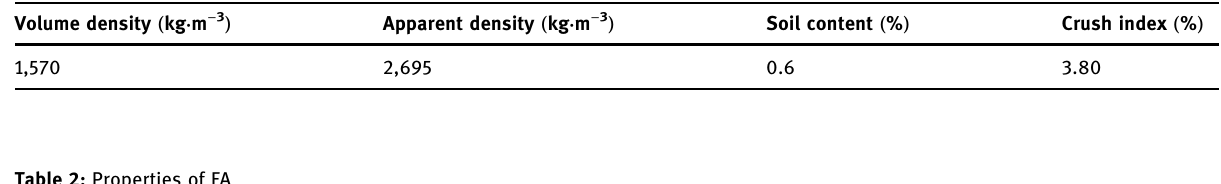
Table 2: Properties of